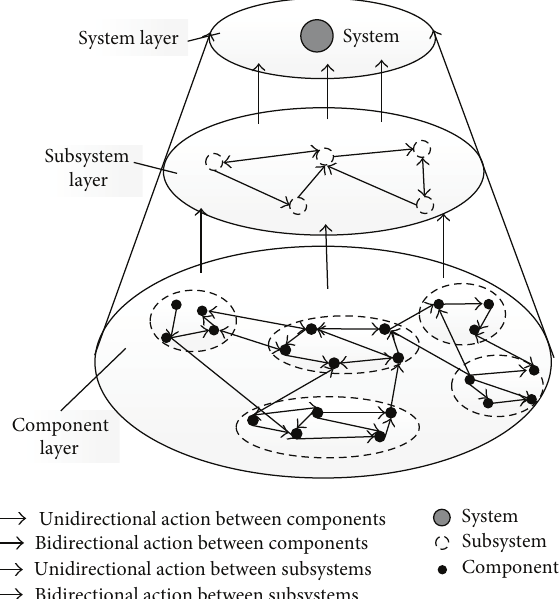
Figure 2: Reliability network modeling on the system with dependent